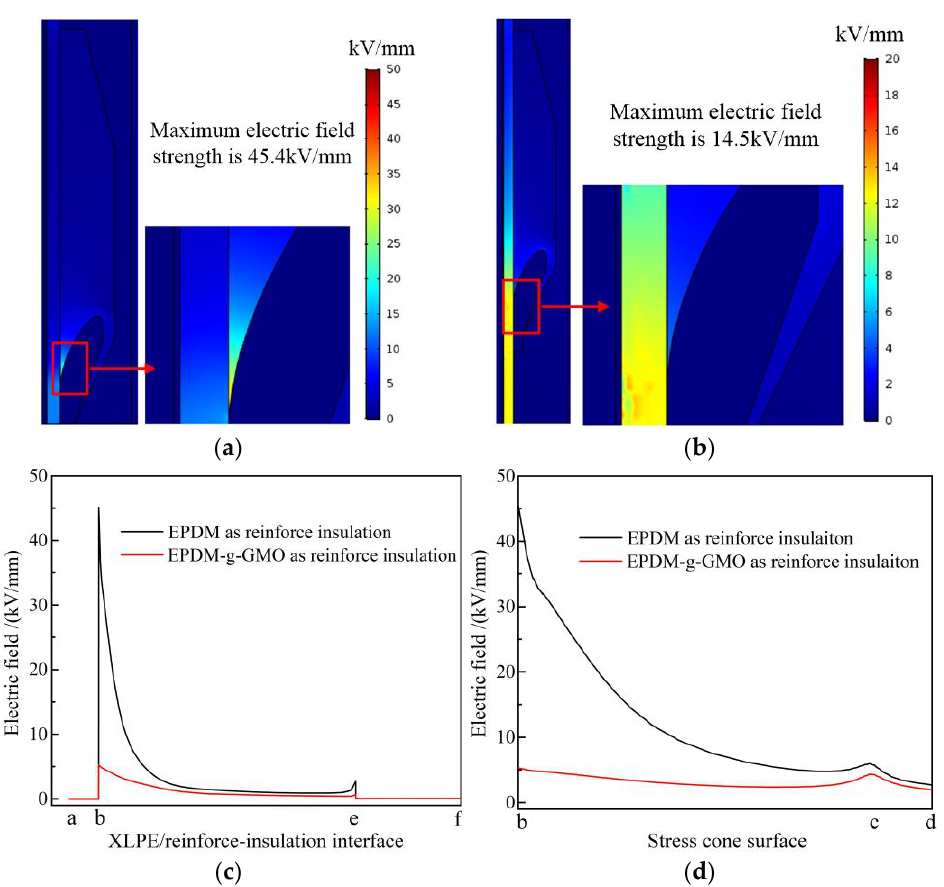
Figure 10. DC steady-state electric fields in cable terminals with ( a ) EPDM and ( b ) EPDM-g-GMO as reinforce insulation, and the tangential electric field varying along ( c ) XLPE/reinforced-insulation interface and ( d ) stress cone surface.